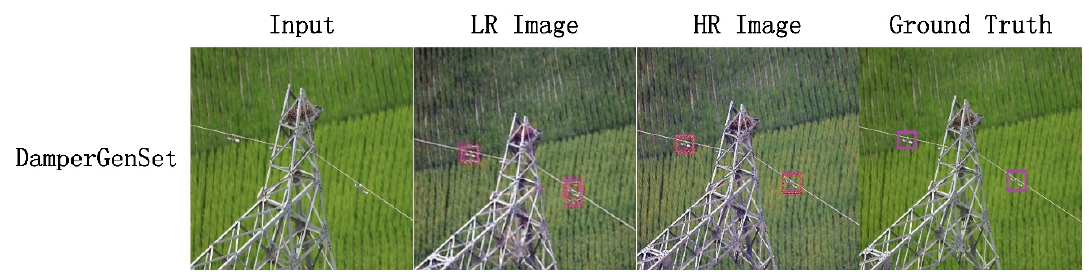
Figure 1. Test examples of our model on DamperGenSet.